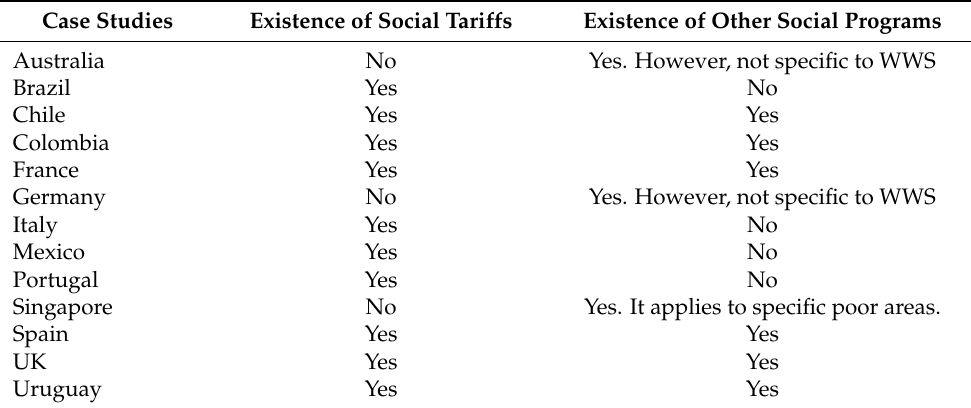
Table 2. Case study assistance